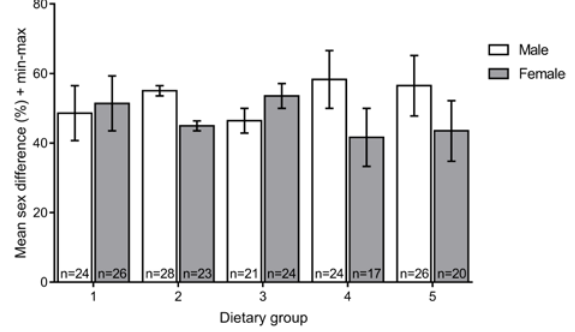
Figure 3. Mean sex ratio for each dietary group at 90 dpf. No statistically significant differences were found among the five dietary regimens. Group 1, Zeb. + Rot. <60 dpf, Zeb. >60 dpf; Group 2: Gem. + Rot. <60 dpf, Gem. >60 dpf; Group 3, Zeb. + Rot. <15 dpf, Zeb. >15 dpf; Group 4, Gem. + Rot. <15 dpf, Gem. >15 dpf; Group 5, Gem. + Rot. <60 dpf, Zeb. >60 dpf (Zeb = Zebrafeed ® ; Gem = GemmaMicro ® ; Rot = rotifers).